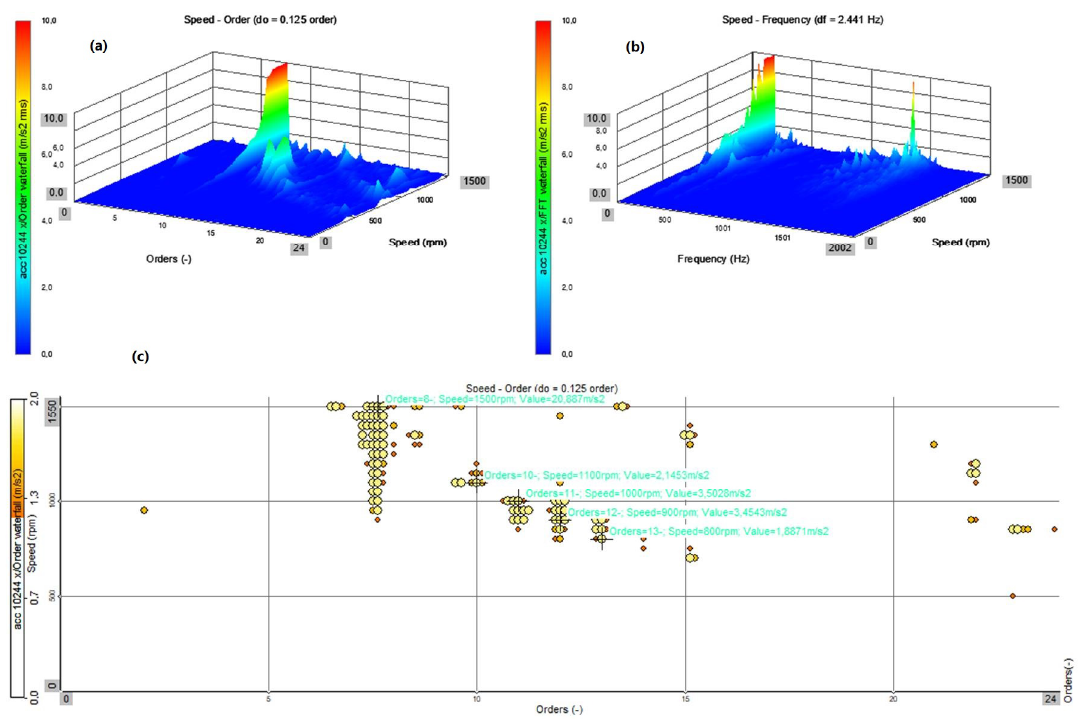
Figure 15. Start-up—locked coupling (left rotation): ( a ) 3D view on the plane: order–rotational speed (rpm); ( b ) 3D view on the plane: frequency–rotational speed (rpm); and ( c ) Campbell’s diagram representing the range of amplitude values divided into levels and presented as a function of the order and rotational speed